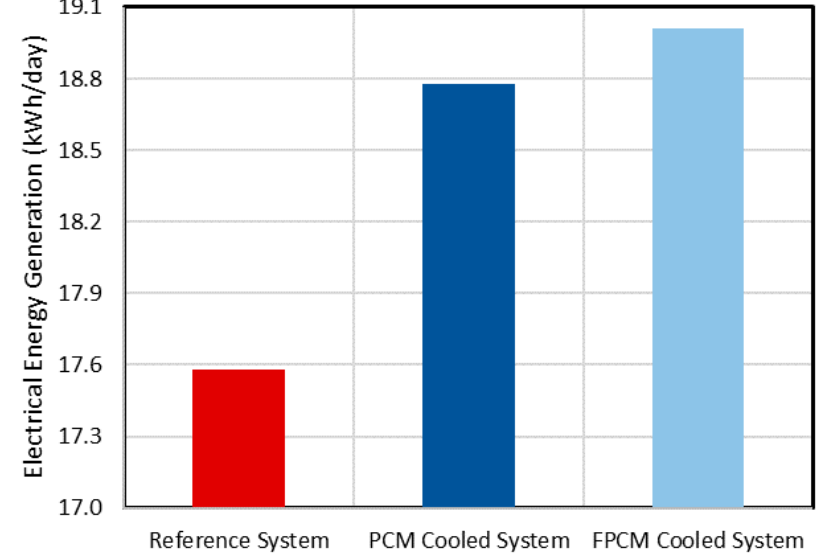
Figure 9. Daily electrical energy generation by reference system, PCM cooled and FPCM cooled systems.